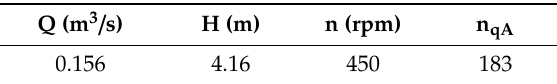
Table 1. Hydro turbine rated quantities.